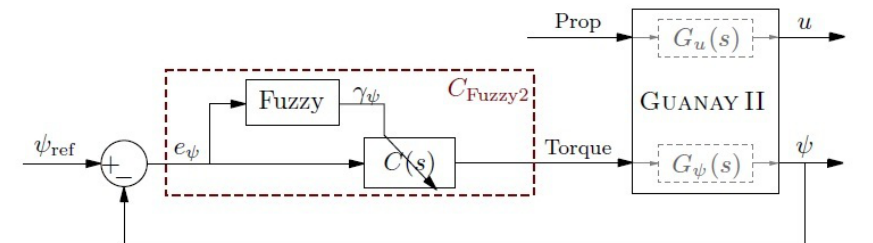
Figure 17. Fuzzy control regarding the yaw error.